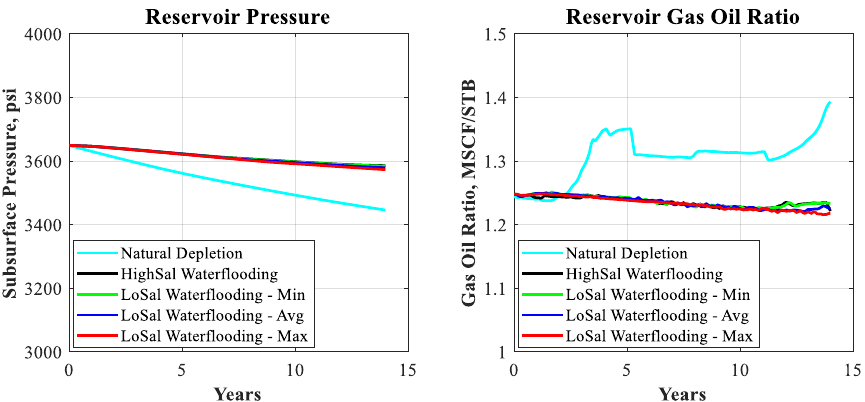
Figure 15. Comparison of the pressure support to the Qamchuqa reservoir during high salinity and low salinity waterflooding, where a similar impact was observed for both flooding schemes on the reservoir subsurface pressure and the produced gas-oil ratio. The natural depletion was provided for comparison.